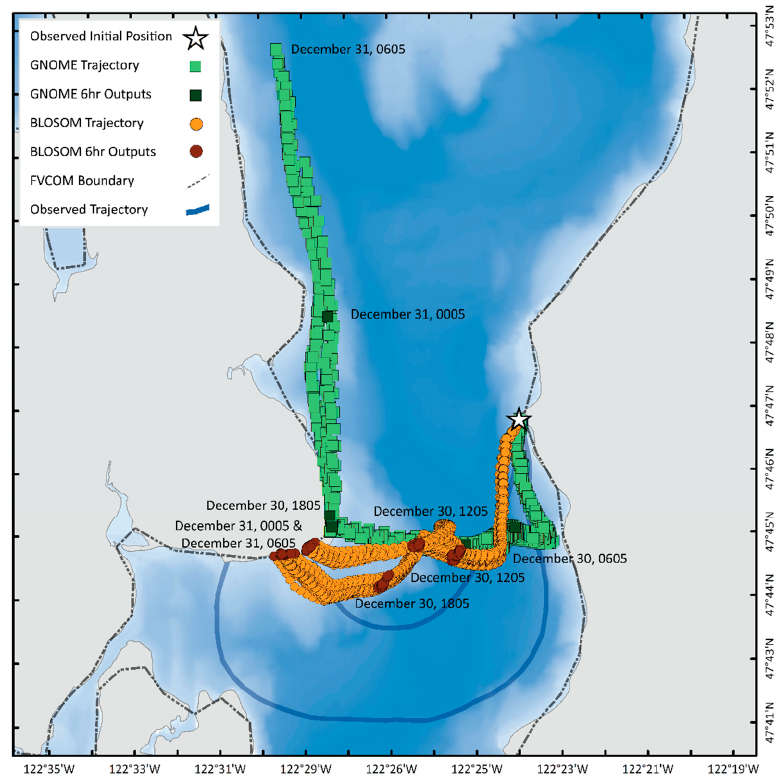
Figure A3. Same as Figure A1, with both models using a computational time step of 18 min. J. Mar. Sci. Eng. 2018 , 6 , x